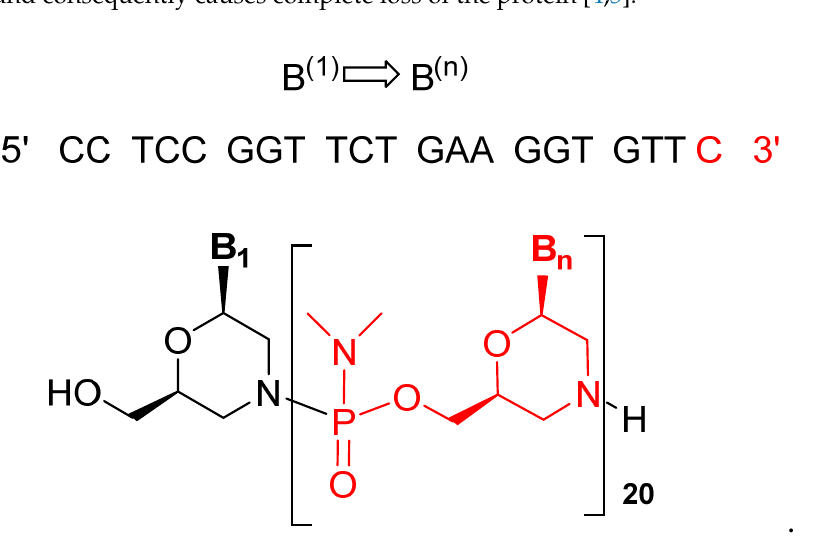
Figure 2. Structure of viltolarsen (Viltepso TM ).